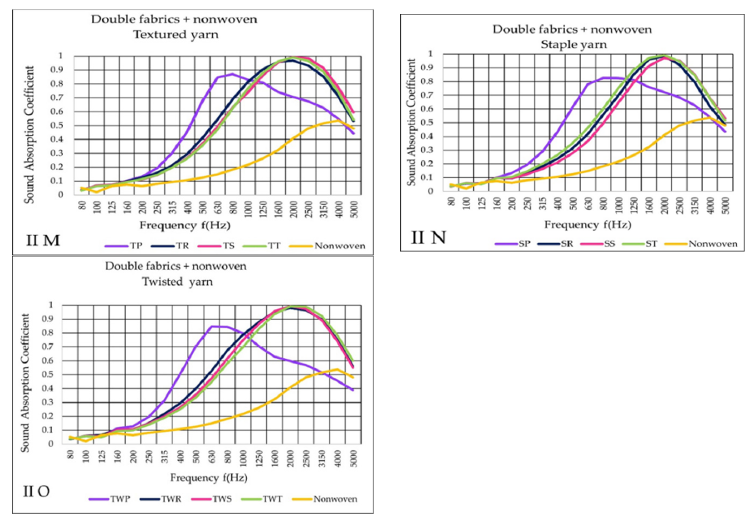
Figure 9. Sound absorption coefficient ( α ) versus frequency f (Hz) result of II variant ( M – O ) double woven fabric + nonwoven.